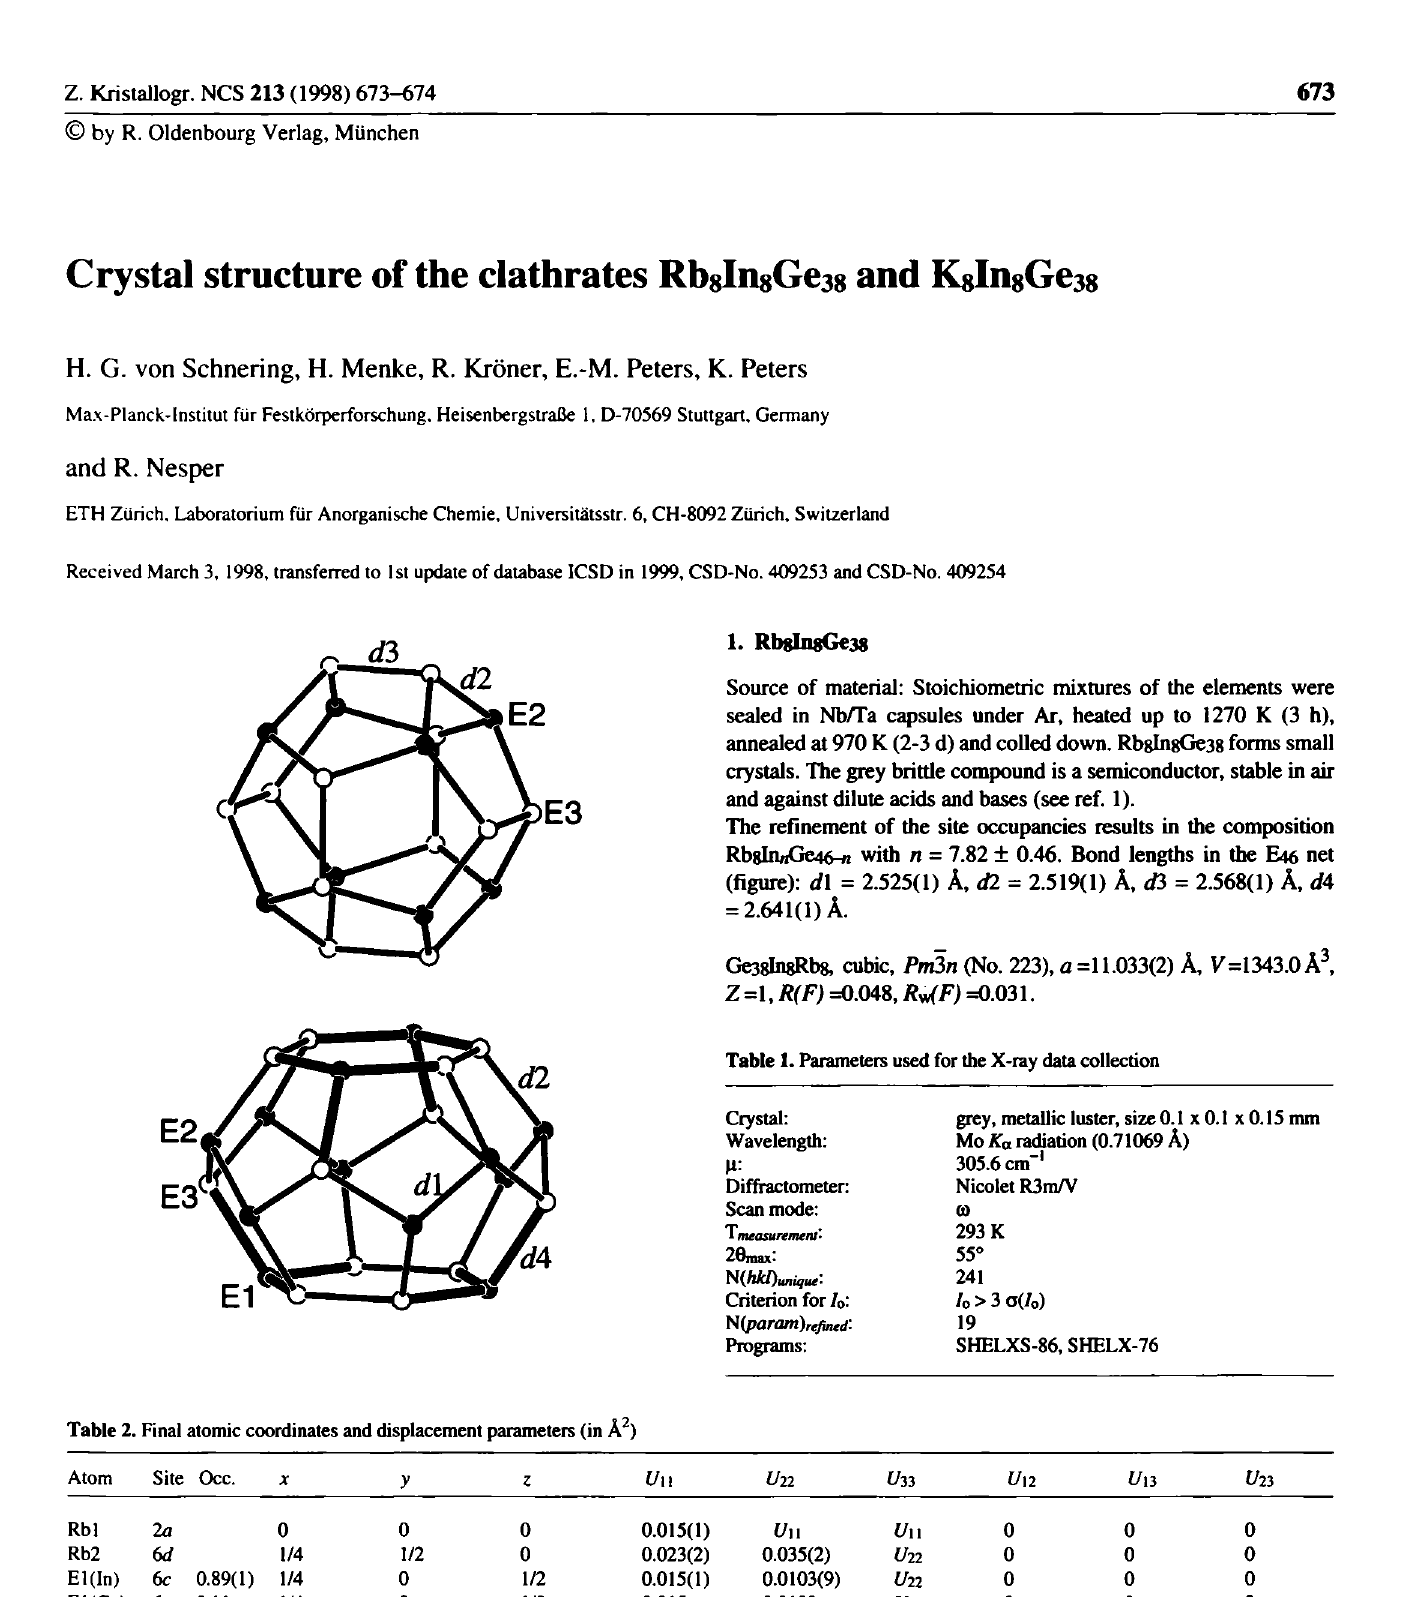
Table 2. Final atomic coordinates and displacement parameters (in Â^) Atom Site